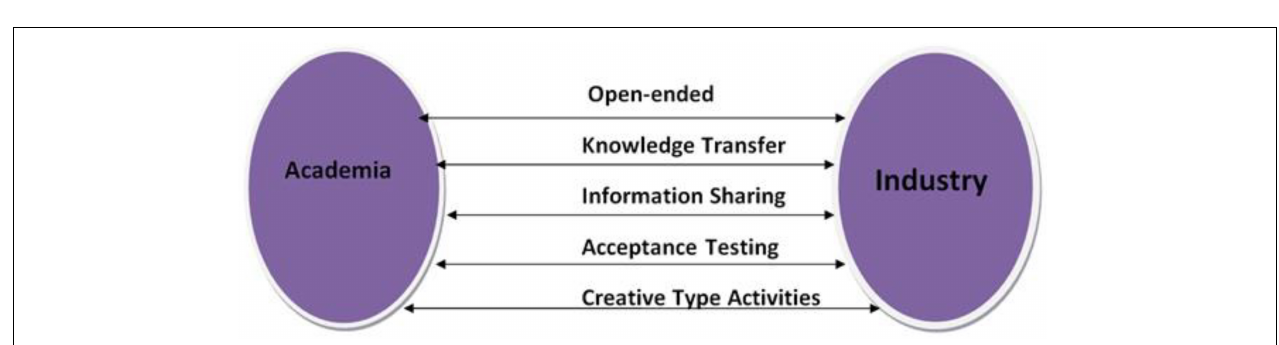
FIGURE 4 | Strategic planning structure for communication between academia and industries.